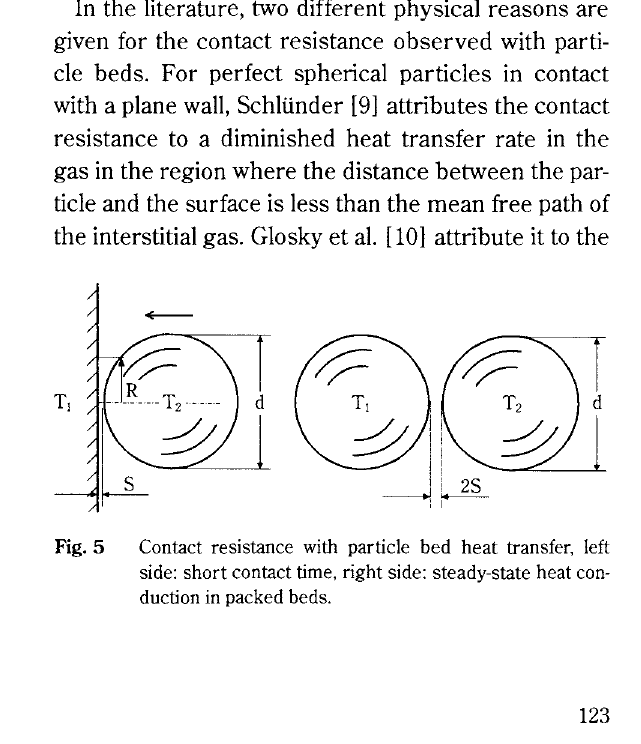
Contact resistance with particle bed heat transfer, left side: short contact time, right side: steady-state heat con· duction in packed